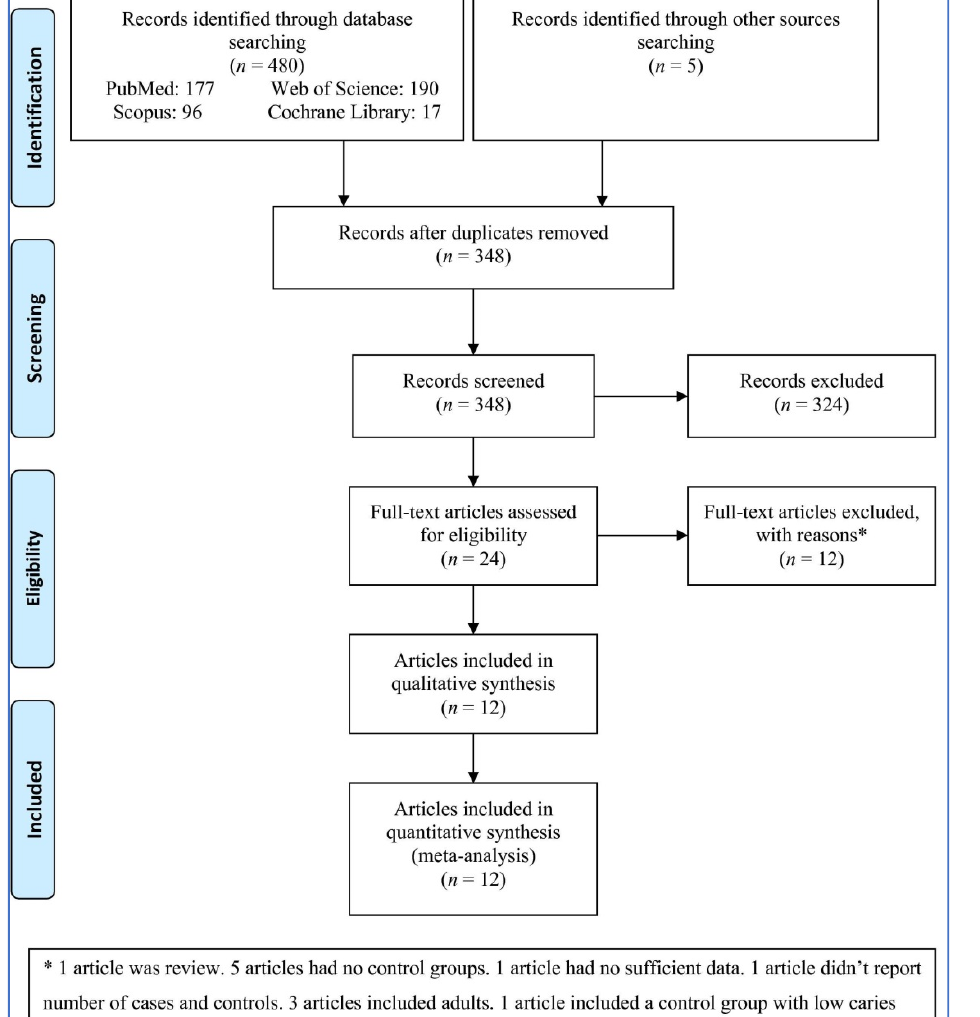
Figure 1. Flowchart demonstrating the study selection procedure. “*” means the reasons of excluding of the full ‐ text articles.